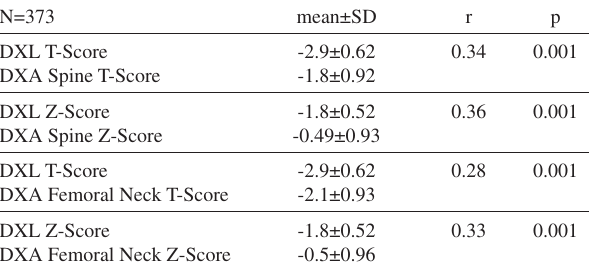
Table 4 - Correlation between DXL T- and Z- scores, and DXA T- and Z-scores at the spine and femoral neck (r=Pearson correlation coefficient)